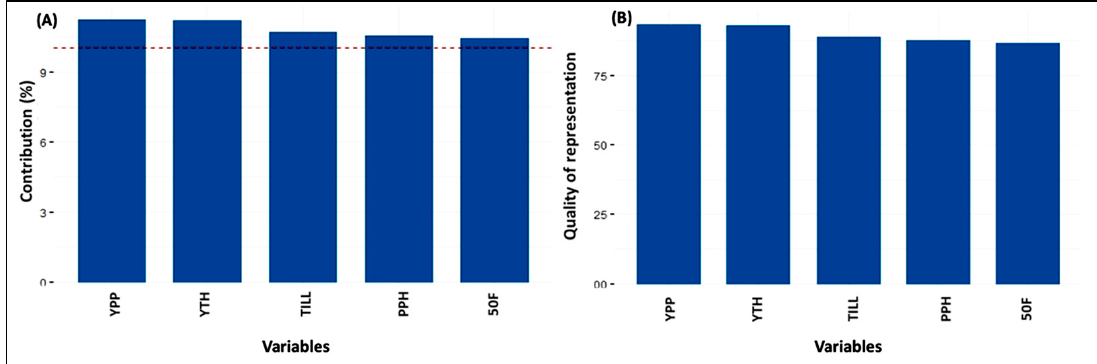
Figure 4. Graphical representation on ( A ) percent of contribution and ( B ) quality of representation of top 5 variables to principal components 1-2-3-4-5.